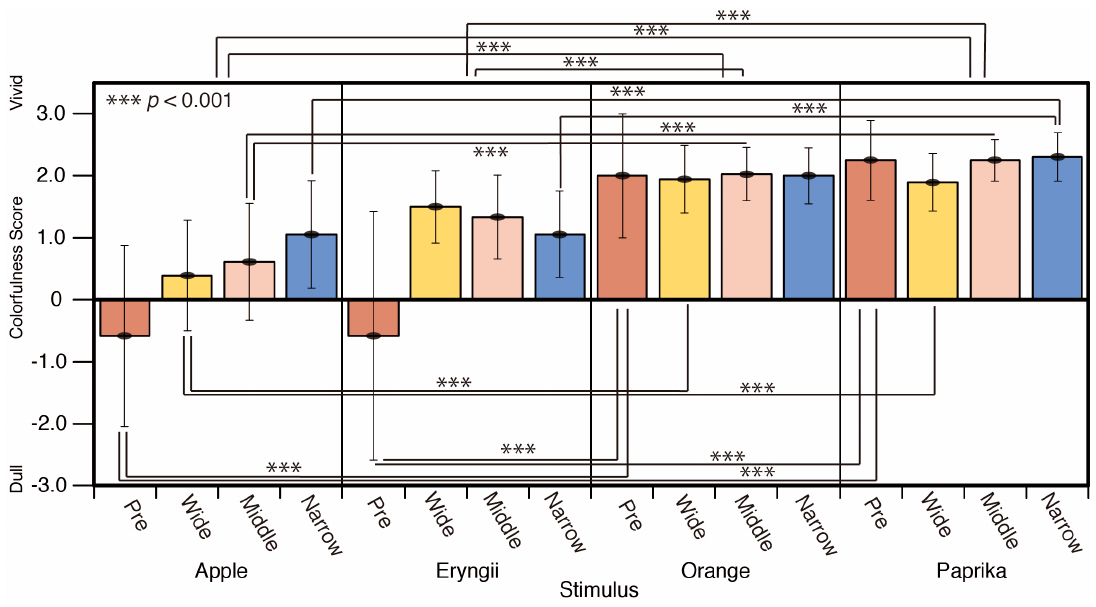
Figure 14. Colorfulness scores and Stimuli.